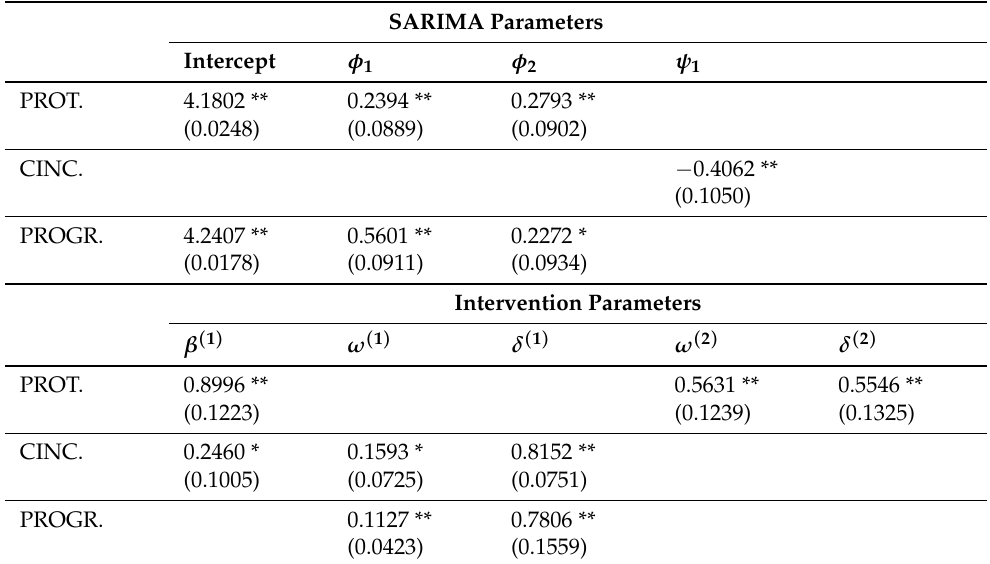
Table 2. Estimation results: coefficients and standard errors in parentheses. SARIMA